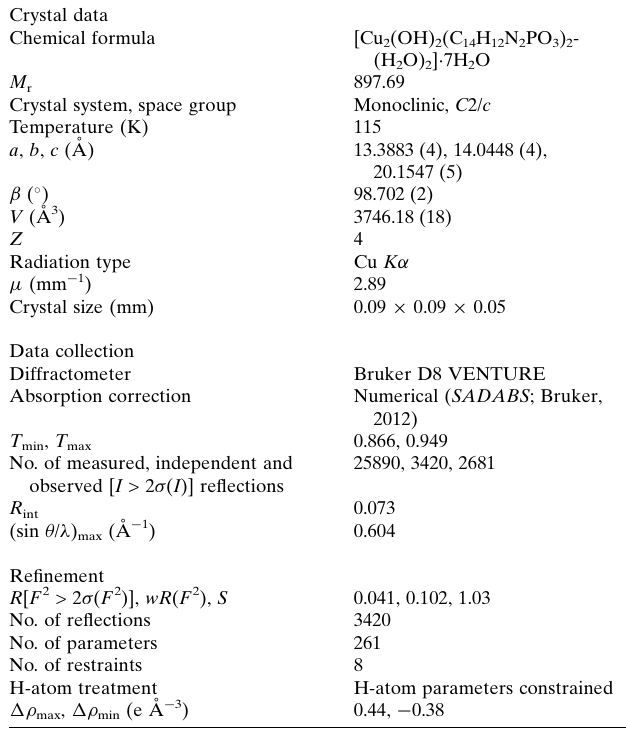
Table 2 Experimental details. Crystal data Chemical